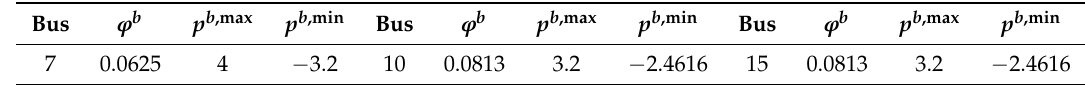
Table 4. BESS location and